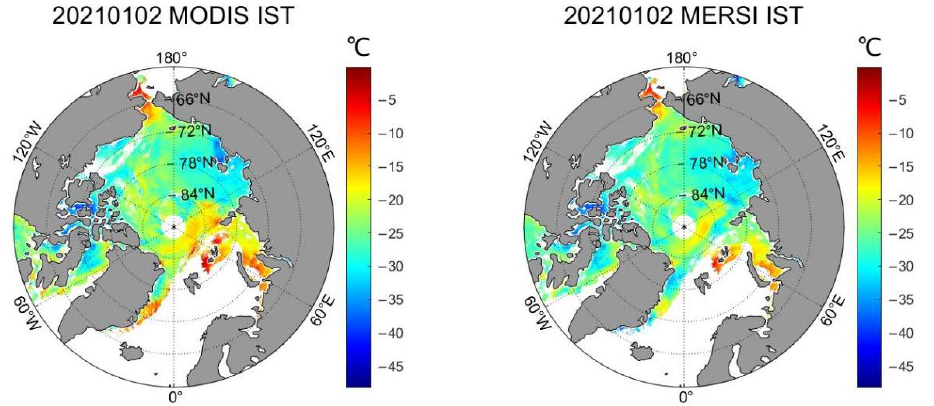
Figure 6. Comparison of the MODIS MYD29 product and the MERSI IST before calibration at 19:50 on 2 January 2021.